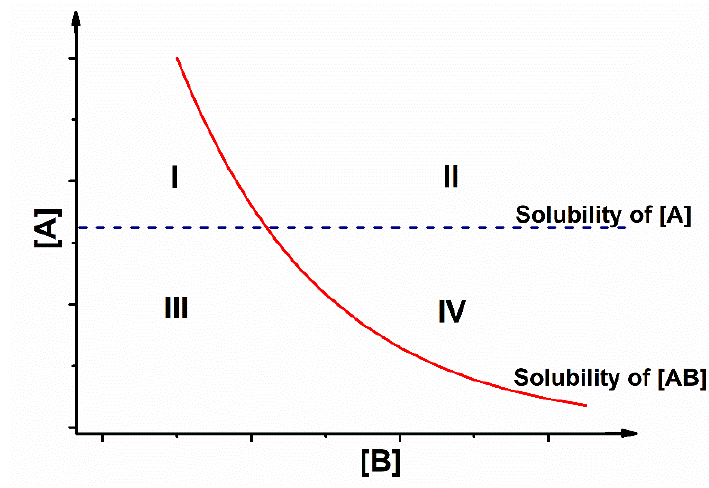
Figure 2. Solubility of an AB cocrystal in solution. [A]: Concentration of the drug; [B]: concentration of the coformer. Lines represent solubilities of drug A and cocrystal AB. Region I: supersaturated solution in relation to the drug and unsaturated in relation to the cocrystal. Region II: supersaturated solution in relation to drug and cocrystal. Region III: unsaturated solution. Region IV: supersaturated solution in relation to the cocrystal and unsaturated in relation to the drug. Source: Adapted from Kuminek et al. (2016) with permission from the publisher.